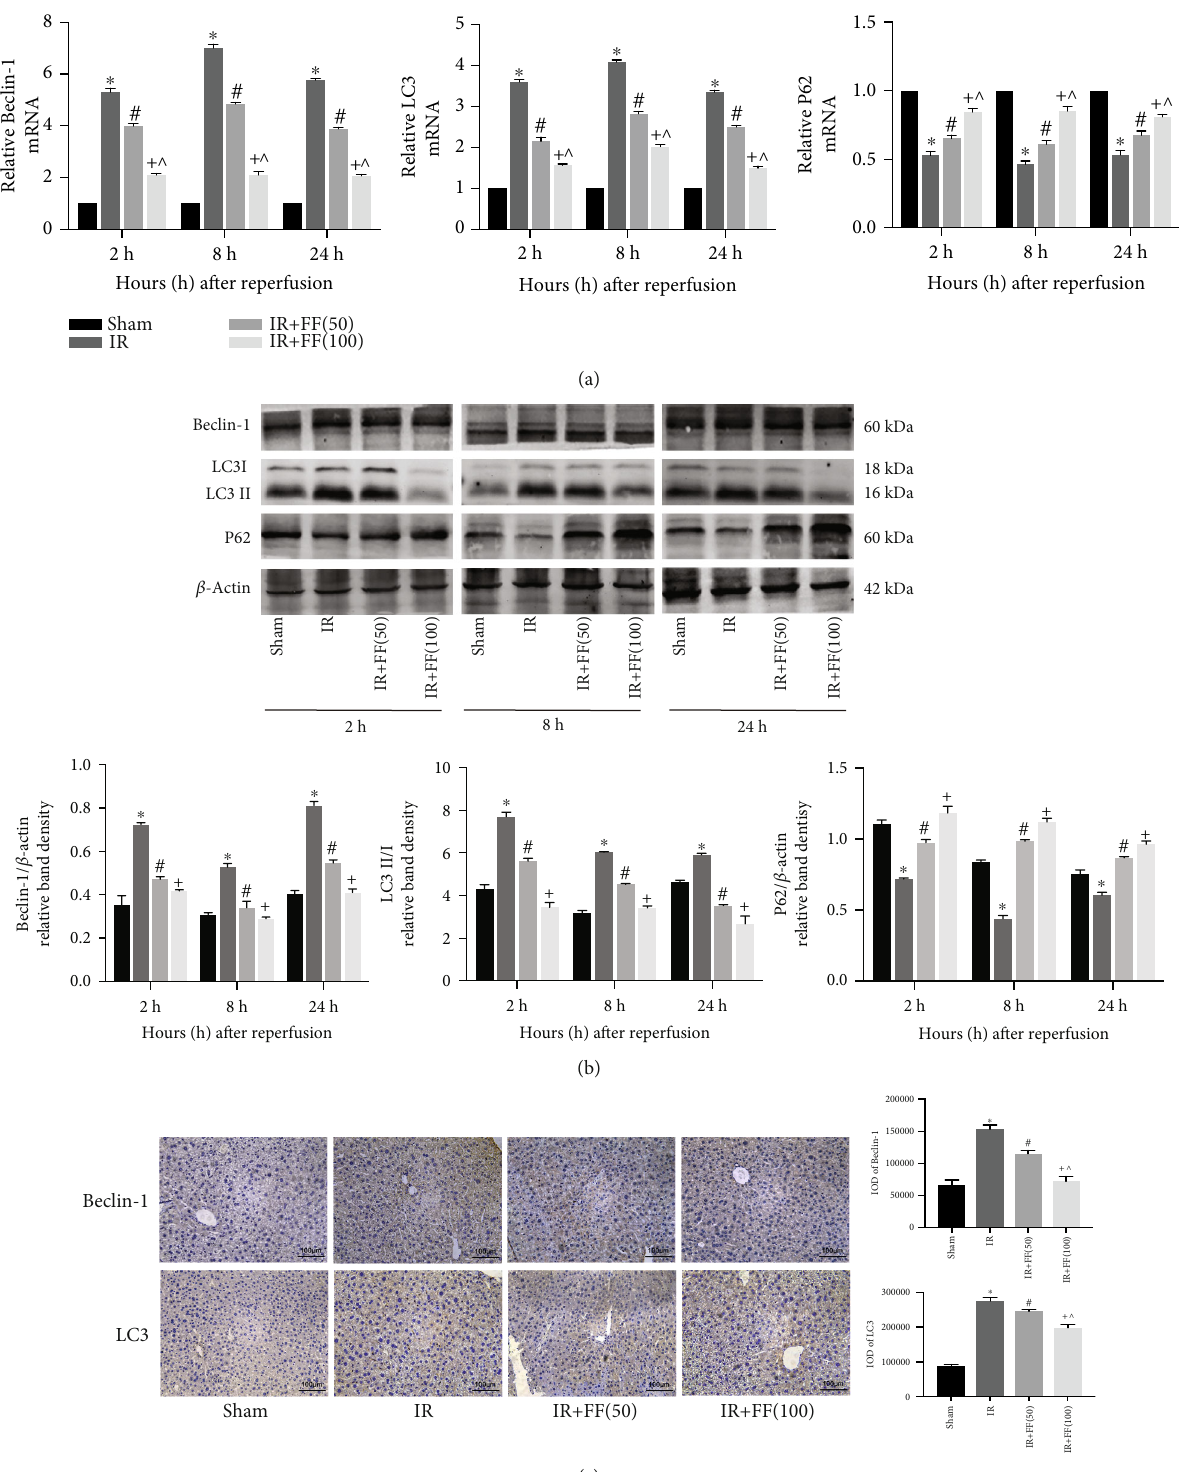
Figure 4: Feno fi brate inhibited autophagy activity during IR injury. (a) Relative Beclin-1, LC3, and P62 mRNA levels were determined by qRT-PCR. (b) Western blot analysis of Beclin-1, LC3, and P62 protein levels. The western blot results were quanti fi ed with ImageJ 8.0 software. (c) Beclin-1 and LC3 protein expression in liver tissues at 8 hours after reperfusion was shown by immunohistochemical staining (200x). Final evaluations were made using Image-Pro Plus 6.0 software to calculate the IOD of the positive staining area. Data are presented as mean ± SD ( n = 6 ; ∗ P < 0 : 05 for IR vs. sham; # P < 0 : 05 for IR+FF (50) vs. IR; + P < 0 : 05 for IR+FF (100) vs. IR; ^ P < 0 : 05 for IR+FF (50) vs. IR+FF (100)) (reproduced from Ji et al.